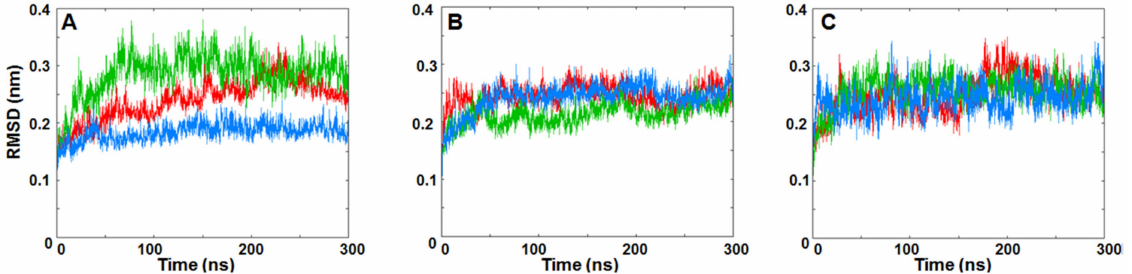
Figure 7. RMSDs of IRE1 back-to-back dimer C α atoms during three MD replicas for ( A ) native back-to-back dimer from crystal structure (PDB code: 4YZC), ( B ) KIRA docked in PDB 4YZC structure, and ( C ) protein–protein docked pose of PDB 4U6R in the back-to-back dimer form. Red for Replica 1, green for Replica 2, and blue for Replica 3,